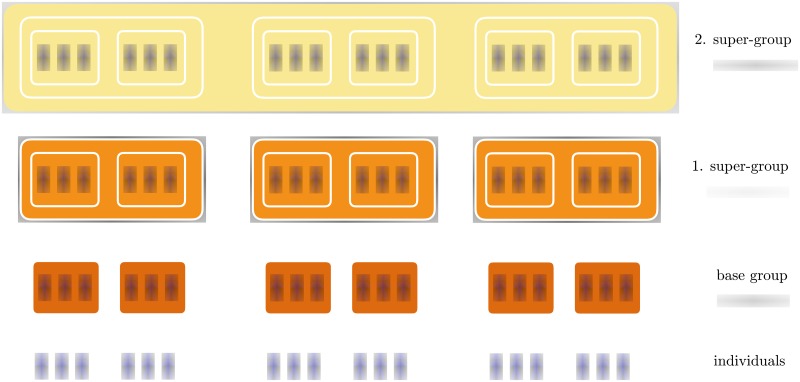
Illustration of the hierarchical organization.We show the case with p = 2, i.e. 3 hierarchical levels (without counting the individual level). We start from N = 18 individuals. The base groups are of size 3 (N0 = q0 = 3), i.e. three individuals together form one group. The next groups (the first super-groups) are of size 2 (q1 = 2, N1 = q1 ⋅ q0 = 6), i.e. two base-groups together form one higher order group. The second super-group (and also the top level) is again of size 3 (q2 = 3, N2 = q0 ⋅ q1 ⋅ q2 = N = 18).